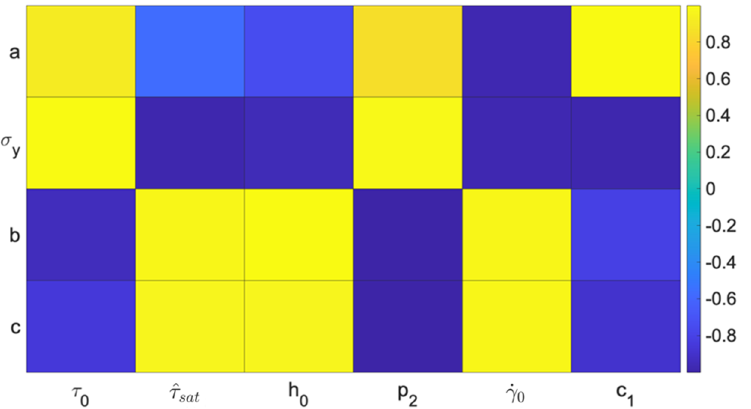
Figure 15. A heatmap representing the correlation between the crystal plasticity parameters and the Voce-type hardening parameters. Voce-type hardening